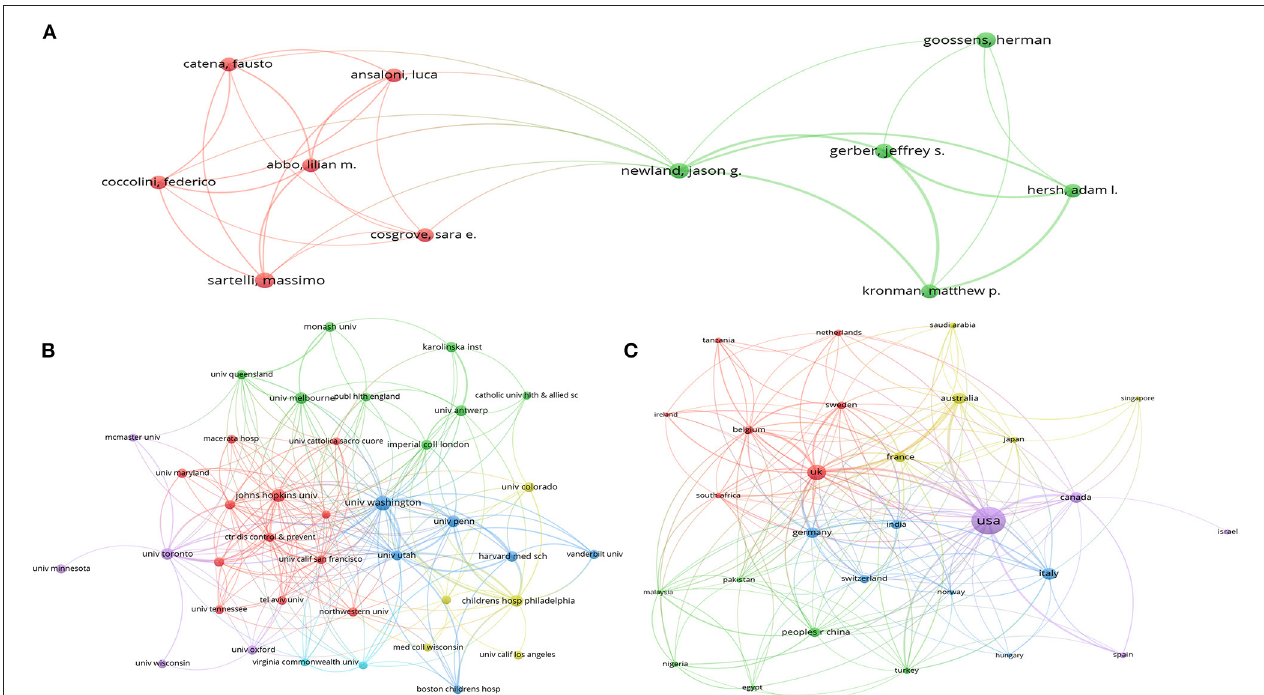
FIGURE 5 | Bibliometric analysis of the citations. (A) The citations of authors. Two clusters with different colors were shown. Jason G Newland in green cluster was the most cited author (1,284 times). (B) The citations of organizations. J University of Washington in blue cluster (cited 1,258 times) has the largest number of published articles. (C) The citations of countries. Five clusters with different colors indicate were shown and USA in purple was cited most (cited 3,307 times). The size of circles indicates the counts of